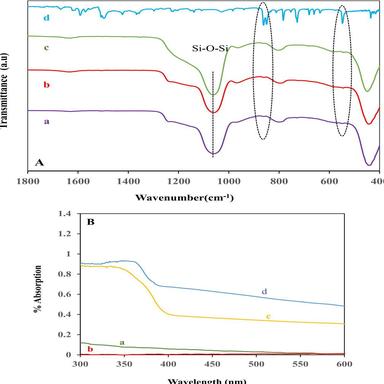
(A) FT-IR of Zn complex incorporated ordered mesoporous materials and pure Zn complex (a) MCM-41-S-Zn, (b) MCM-48-S-Zn, (c) SBA-15-S-Zn, (d) Pure Zn complex and Fig. 3(B) UV–Vis of Zn complex incorporated ordered mesoporous materials and pure Zn complex (a) MCM-48, (b) MCM-48-SO3H, (c) MCM-48-S-Zn and (d) Pure Zn complex.